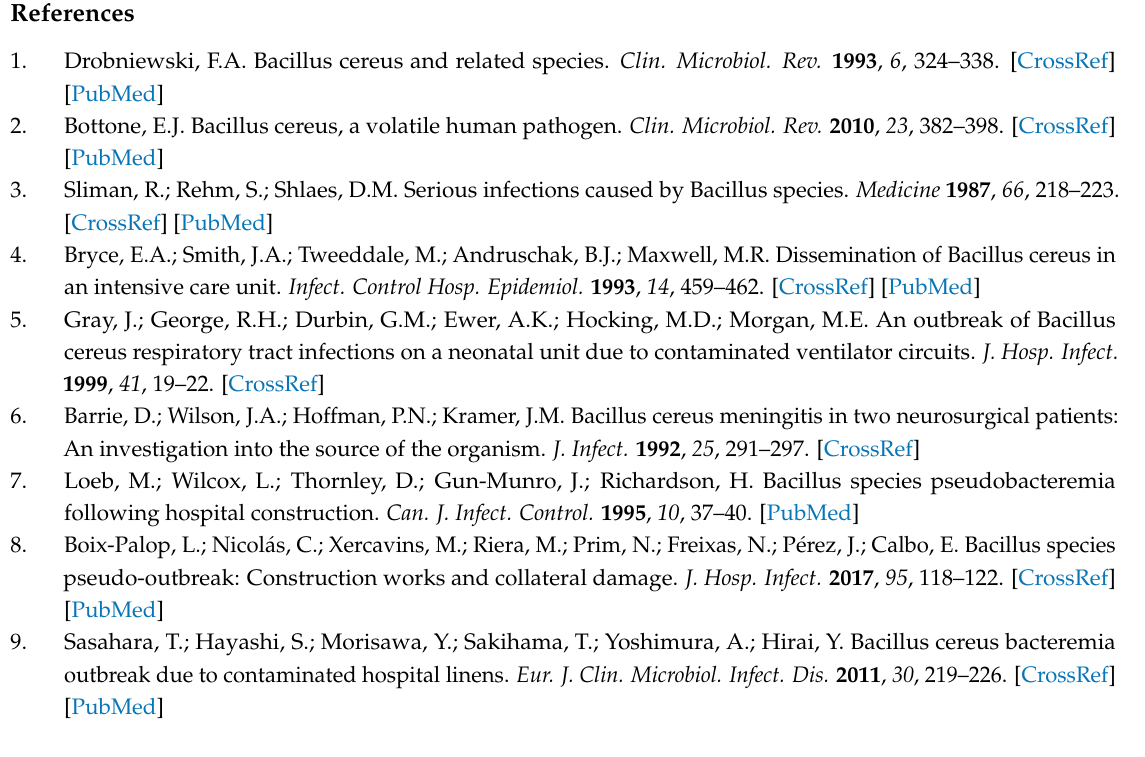
s1, Table S1: Climatological variables and incidence in Sapporo from 2013–16, Table S2: Background demographic characteristics, date of sampling and admitted ward of